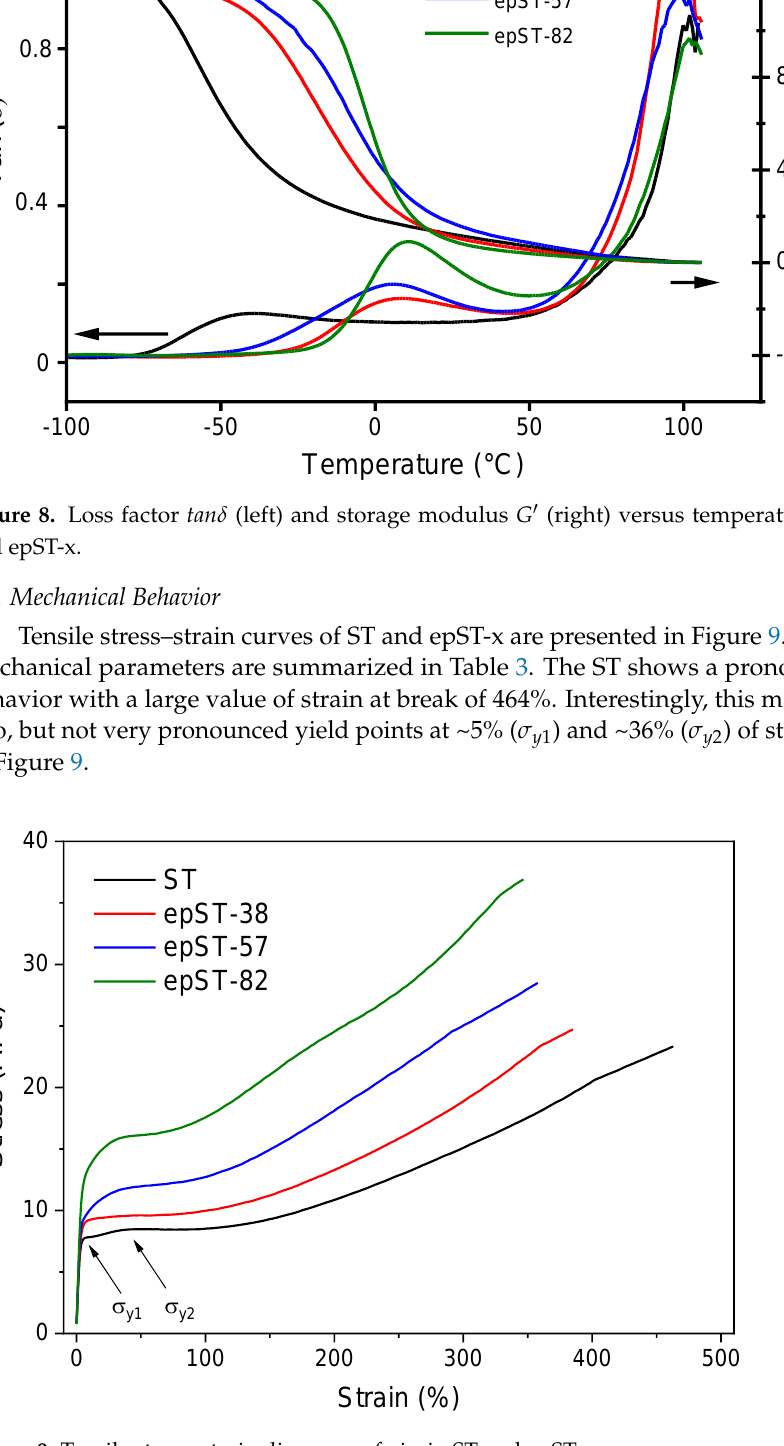
Figure 9. Tensile stress – strain diagrams of virgin ST and epST-x. Table 3. Some of the tensile mechanical characteristics of ST and epST-x.